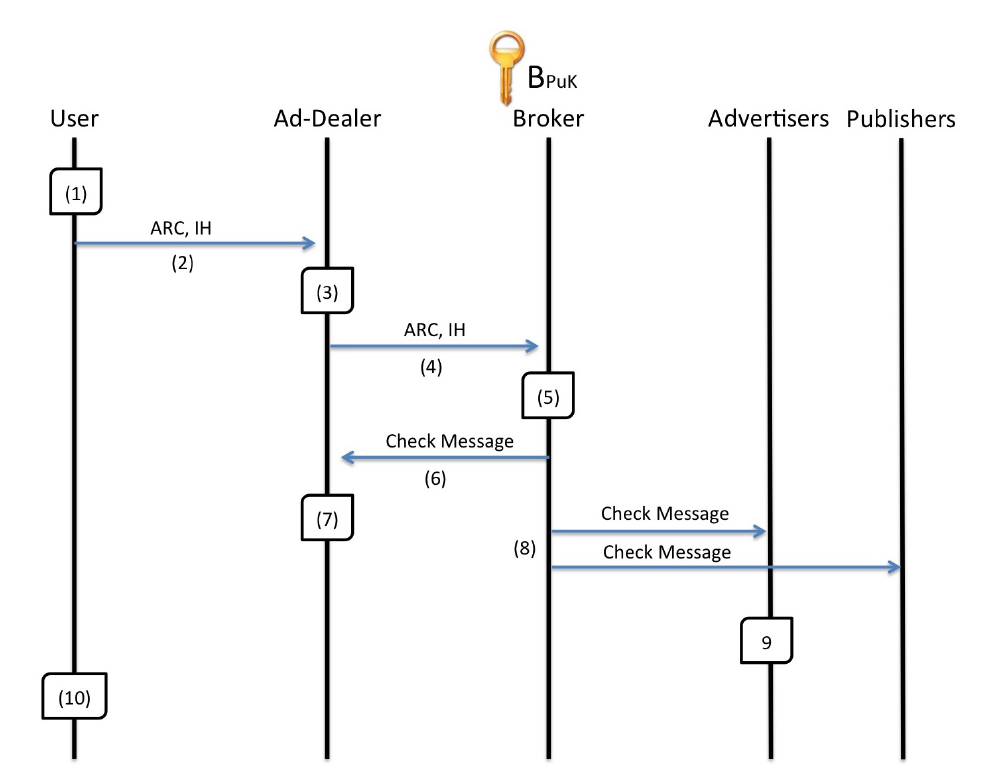
Figure 12. Ad Report Submission